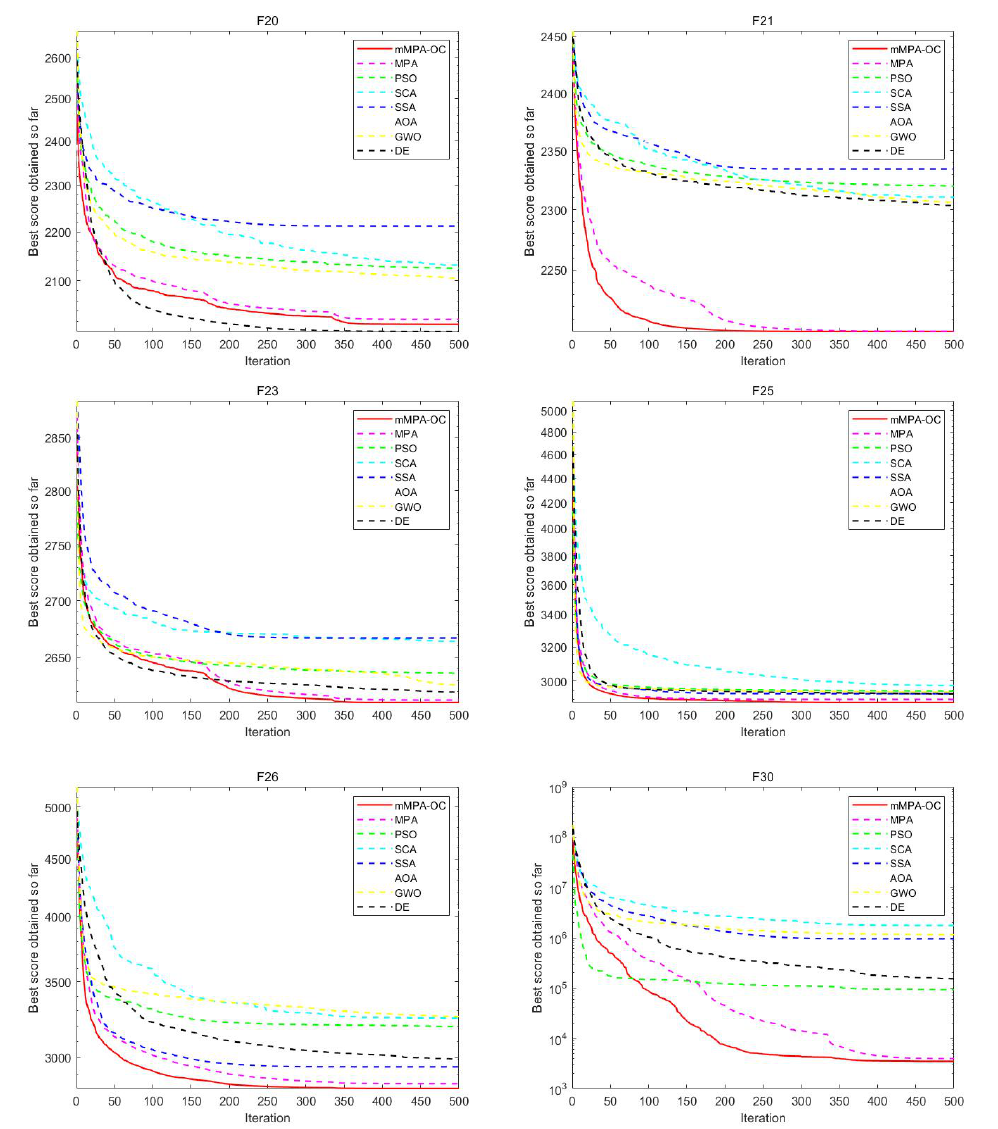
Figure 2. Convergence curve of CEC-2017 test function (10